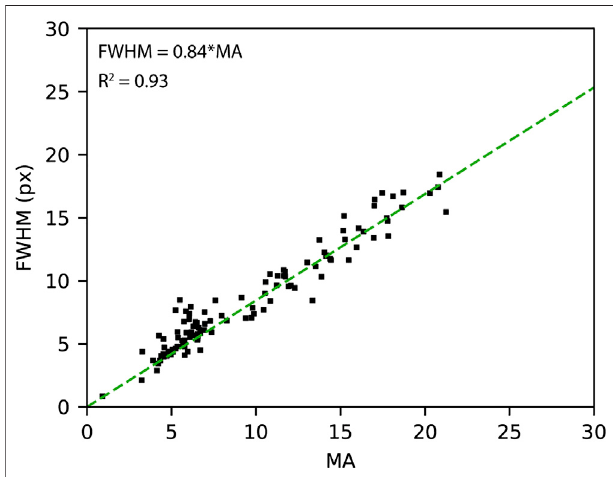
FIGURE 7 | MA vs FWHM plot showing the correlation between the FTP ’ s apertures and the anomaly magnitude.